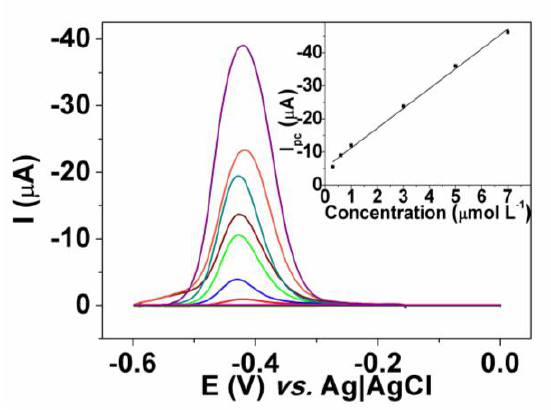
Figure 7. Square wave voltammetry (SWV) obtained under optimized conditions in a 0.04 mol∙L −1 B-R buffer solution with increasing concentrations of AG25: ( a ) blank; ( b ) 1.0 × 10 −7 ; ( c ) 5 × 10 −7 ; ( d ) 1 × 10 −6 ; ( e ) 3 × 10 −6 ; ( f ) 5 × 10 −6 ; and ( g ) to 7.0 × 10 −6 mol∙L −1 . Inset: relation between I pc vs. concentration of AG25. Parameters: pH 4.0, ƒ = 10 Hz and ΔE = 60